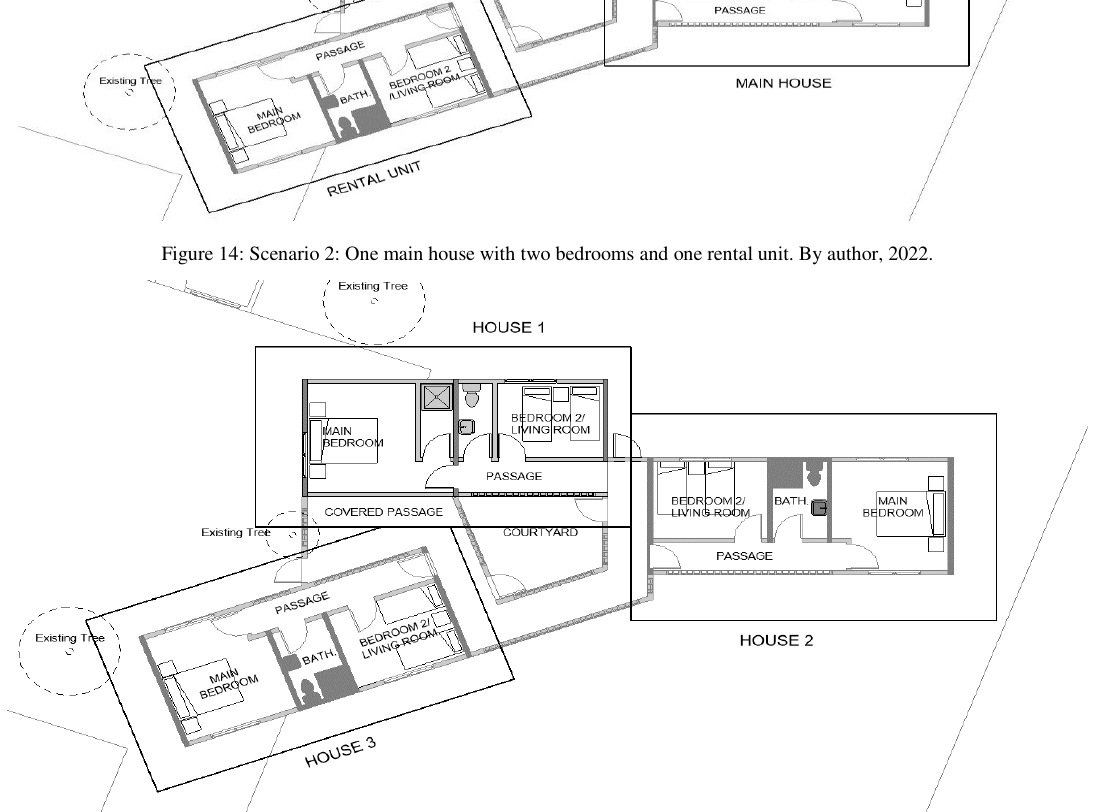
Figure 15: Scenario 3: Three independent houses. By author,